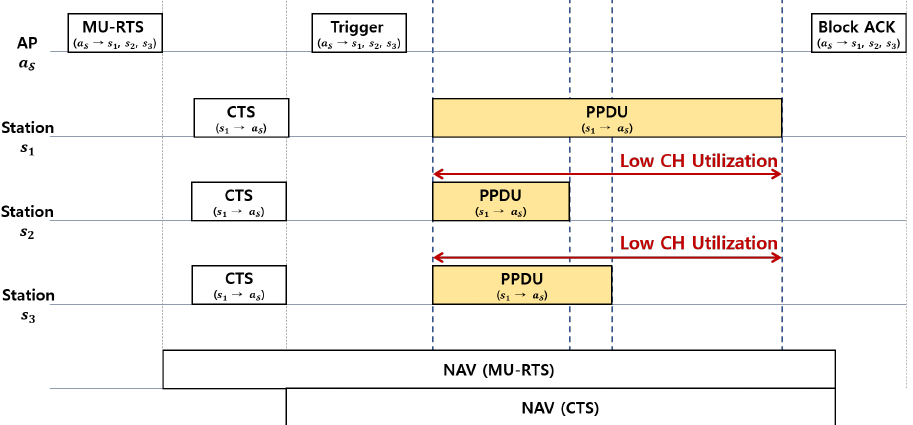
Figure 1. An example of uplink multi-user transmissions in IEEE 802.11ax